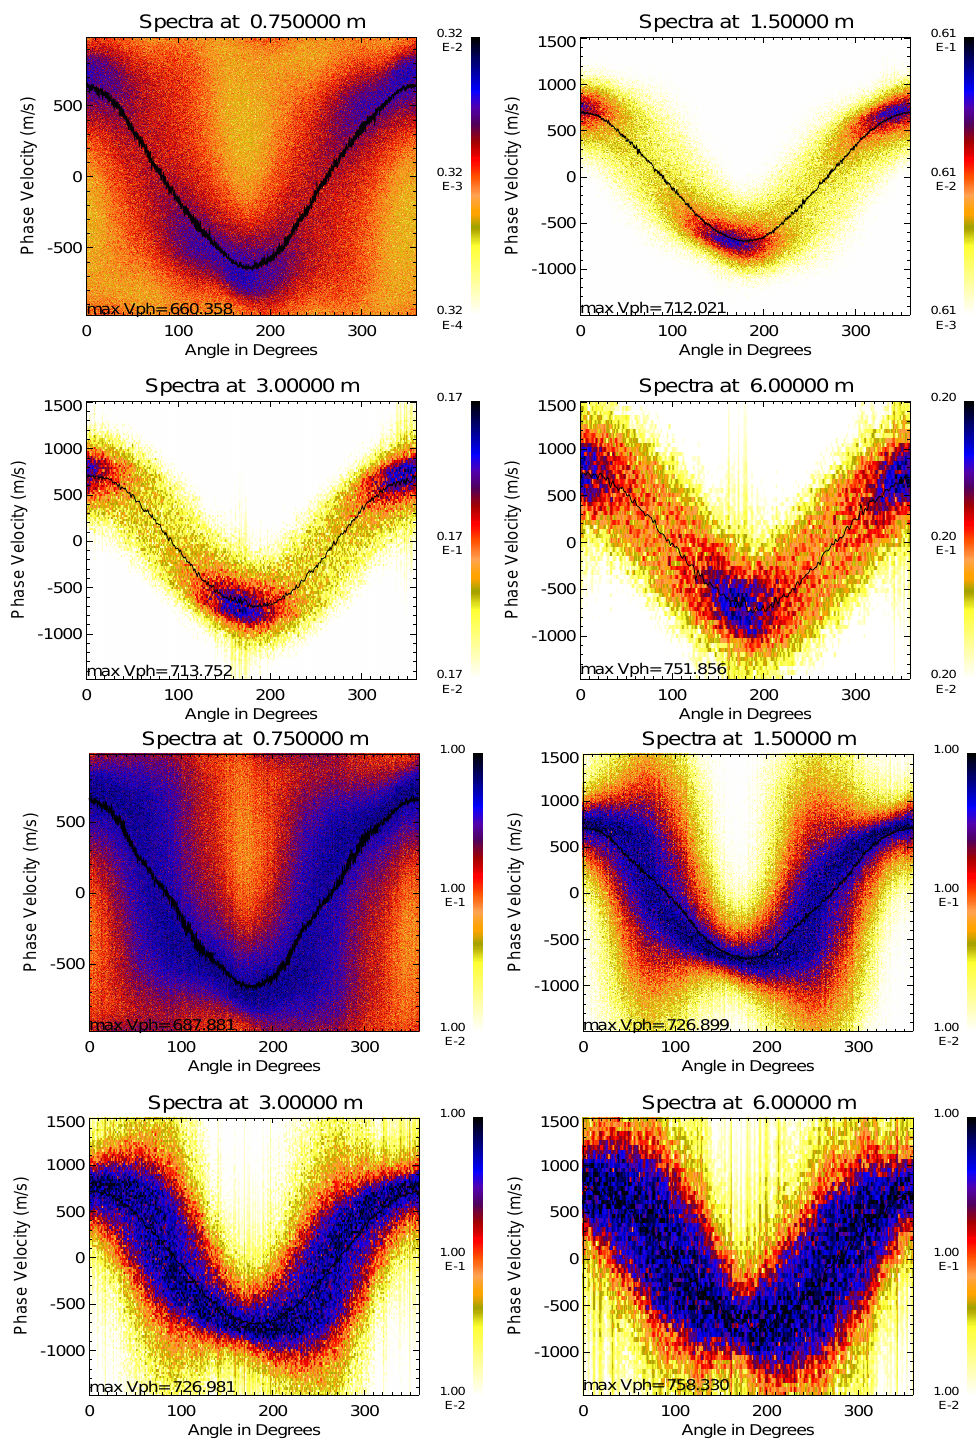
Fig. 5. Spectra comparing v ph = ω/ | k | to angle with respect to the E 0 × B 0 direction for four wavelengths. The top four figures indicate the strength of the signal with the color bar to the right of the image. The bottom four normalize the amplitude of the signal at each angle to the maximum signal strength at that angle, in order to better compare with radar data which generally show normalized spectral amplitudes. The curve drawn through the signal is the moment of the signal at each angle and this indicates the mean phase velocity. The peak value of v ph is listed on the bottom of the